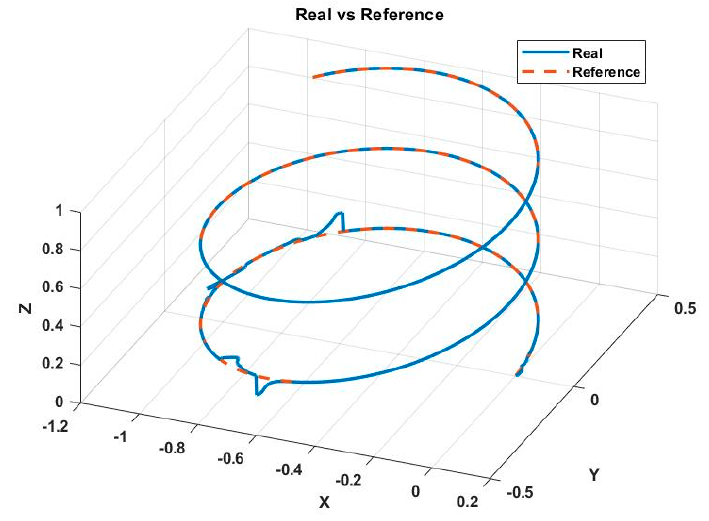
Figure 14. Helicoidal trajectory with perturbance. Real ( 𝐵𝑙𝑢𝑒 𝑆𝑜𝑙𝑖𝑑 𝑙𝑖𝑛𝑒 ) vs. desired ( 𝑅𝑒𝑑 𝑑𝑜𝑡𝑡𝑒𝑑 𝑙𝑖𝑛𝑒 ).